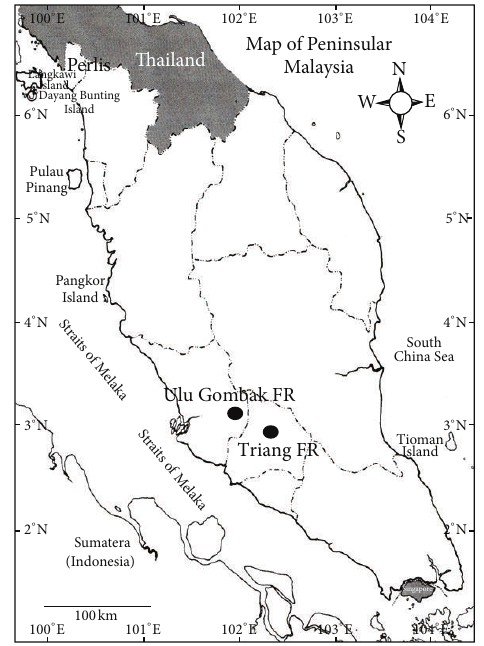
Figure 1: Map showing location of the two study sites in Peninsular Malaysia and Ulu Gombak Forest Reserve (UGFR), Selangor, and Triang Forest Reserve (TFR), Negeri